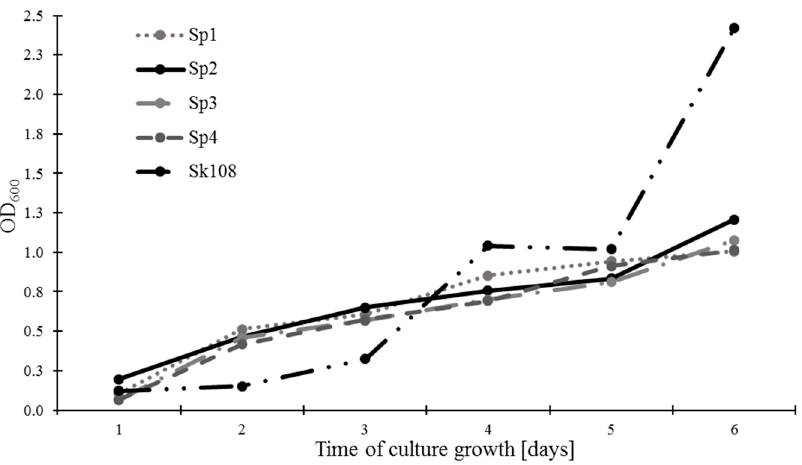
Figure 1. Studied biomass of methanotrophs during culture growth.